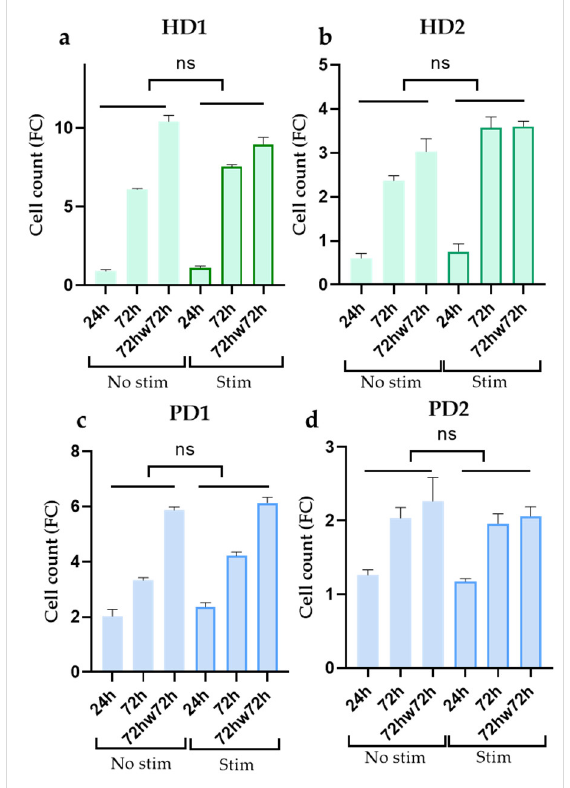
Figure 2. Comparison of the dynamics of cell growth in the absence or presence of inflammatory cytokines ( a , b ) in glial cultures from healthy donors (HD1, HD2); ( c , d ) in glial cultures from PD patients with PARK2 mutations (PD1, PD2) during cultivation. Cell counts were estimated using MTT test. Fold change (FC) in the cell count in each well (n = 3) was calculated relative to the initially seeded 5 × 10 3 cells per well. The data are shown as mean ± SEM at three time points (24 h, 72 h, 72hw72h) for each glial culture. Two-way ANOVA and multiple comparisons corrected with Bonferroni test were used for statistical processing; ns, non-significant.